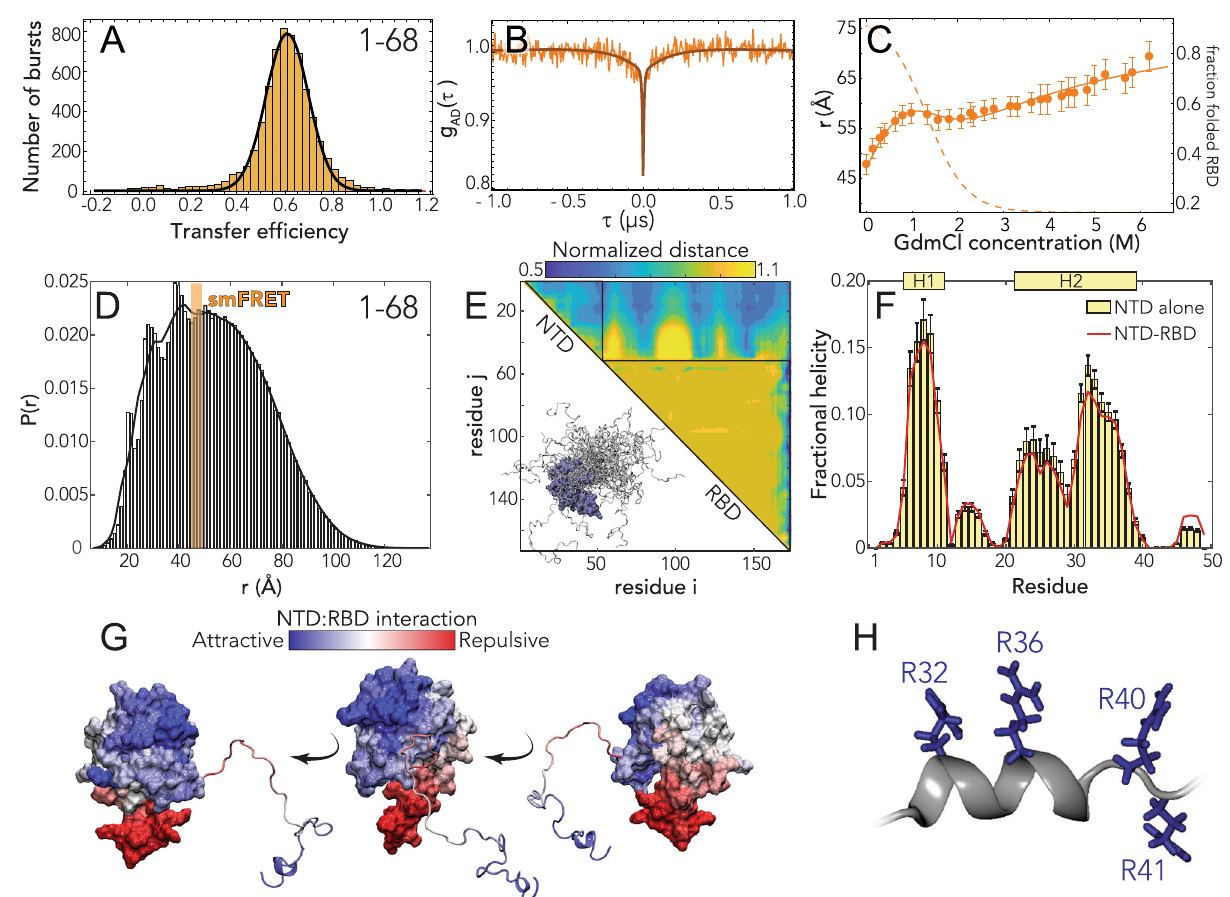
Fig. 2 The N-terminal domain (NTD-FL) is disordered with residual helical motifs. A Histogram of the transfer ef fi ciency distribution measured across the labeling positions 1 and 68 in the context of the full-length protein, under aqueous buffer conditions (50 mM Tris buffer). B Donor – acceptor cross- correlation measured by ns-FCS (see SI). The observed anticorrelated rise is the characteristic signature of FRET dynamics and the timescale associated is directly related to the recon fi guration time of the probed segment. C Root-mean-square interdye distance as extracted from single-molecule FRET experiments across different denaturant concentrations using a Gaussian chain distribution, examining residues 1 – 68 in the context of the full-length protein. The full line represents a fi t to the model in Eq. (S7), which accounts for denaturant binding (see Table S2) and unfolding of the folded RBD. The dashed line represents the estimated fraction of folded RBD across different denaturant concentrations based on Eq. (S8). Error bars represent propagation ±0.03 systematic error in measured transfer ef fi ciencies (see SI). D All-atom simulations of the NTD in the context of RBD reveal good agreement with smFRET-derived average distances. The peaks on the left shoulder of the histogram are due to persistent NTD – RBD interactions in a small subset of simulations. E Normalized distance maps (scaling maps) quantify heterogeneous interaction between every pair of residues in terms of average inter- residue distance normalized by distance expected for the same system if the IDR had no attractive interactions (the excluded volume limit 144 ). Both repulsive (yellow) and attractive (blue) regions are observed for NTD – RBD interactions. F Transient helicity (residues 5 – 11 and 21 – 39) in the NTD in isolation or in the context of the RBD. Perfect pro fi le overlap suggests interaction between the NTD and the RBD does not lead to a loss of helicity. Error bars are standard error of the mean calculated from forty independent simulations. G Projection of normalized distances onto the folded domain reveals repulsion is through electrostatic interaction (positively charged NTD is repelled by the positive face of the RBD, which is proposed to engage in RNA binding) while attractive interactions are between positive, aromatic, and polar residues in the NTD and a slightly negative and hydrophobic surface on the RBD (see Fig. 1B, center). H The C-terminal half of the transient helix H2 encodes an arginine-rich ionic strength of the solution is suf fi cient to alter the equilibrium between these two populations and favor the low transfer ef fi - ciency state (see inset in Fig. 3C). Comparison of the fl uorescence lifetimes and transfer ef fi ciencies indicates that, like the NTD, the transfer ef fi ciencies represent dynamic conformational ensembles sampled by the LINK (Fig. S7A). ns-FCS con fi rms fast dynamics across the measured distribution of transfer ef fi ciencies, with a characteristic recon fi guration time τ r of 120 ± 20 ns (Figs. 3B and S12). This recon fi guration time is compatible with high internal friction effects, as observed for other unstructured proteins 44,45 , but may also account for the drag of the surrounding domains. The root-mean-square interdye distance corresponding to the low of denaturant leads to the rapid loss of the high transfer ef fi ciency